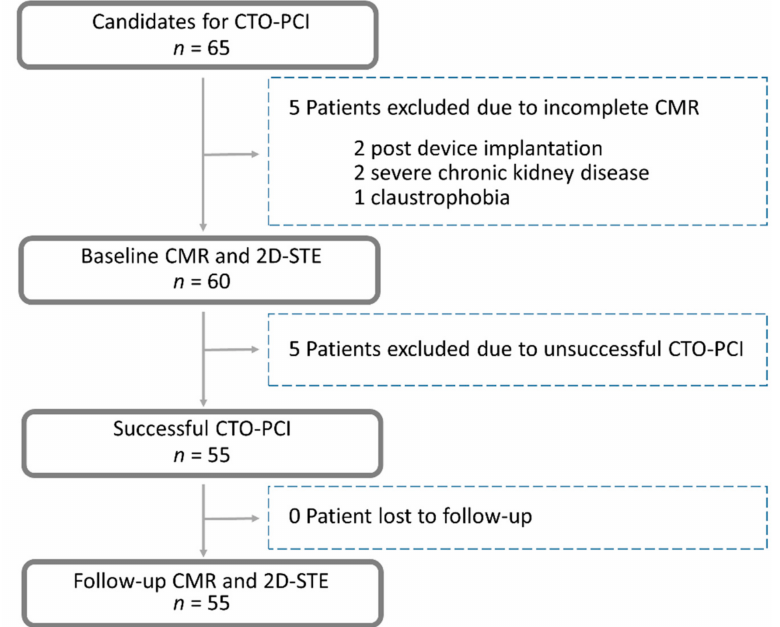
Figure 1. Flow chart of patient enrollment. Abbreviations: CAG, coronary angiography; CMR, cardio- vascular magnetic resonance; CTO, chronic total occlusion; PCI, percutaneous coronary intervention; 2D-STE, two-dimensional speckle-tracking